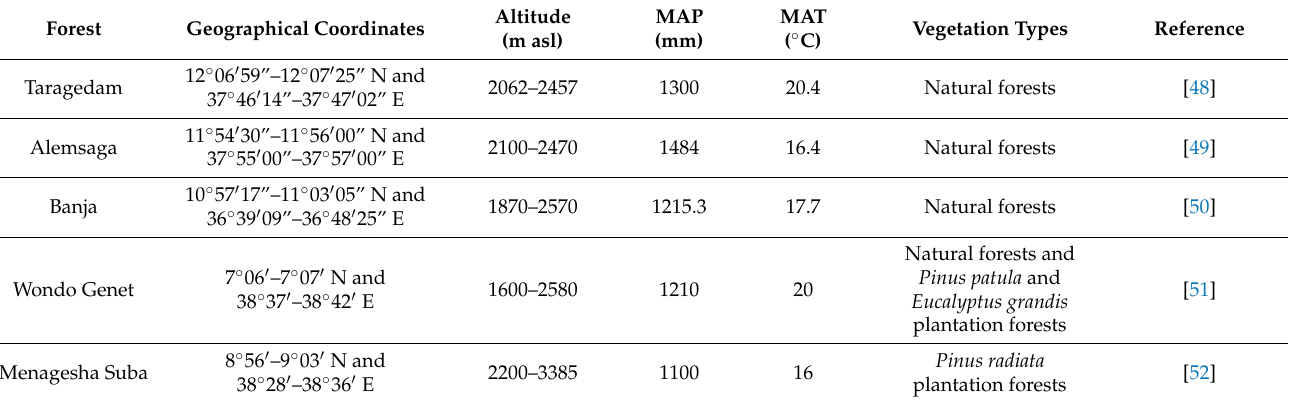
Table 1. Comprehensive descriptions of the forests and the study